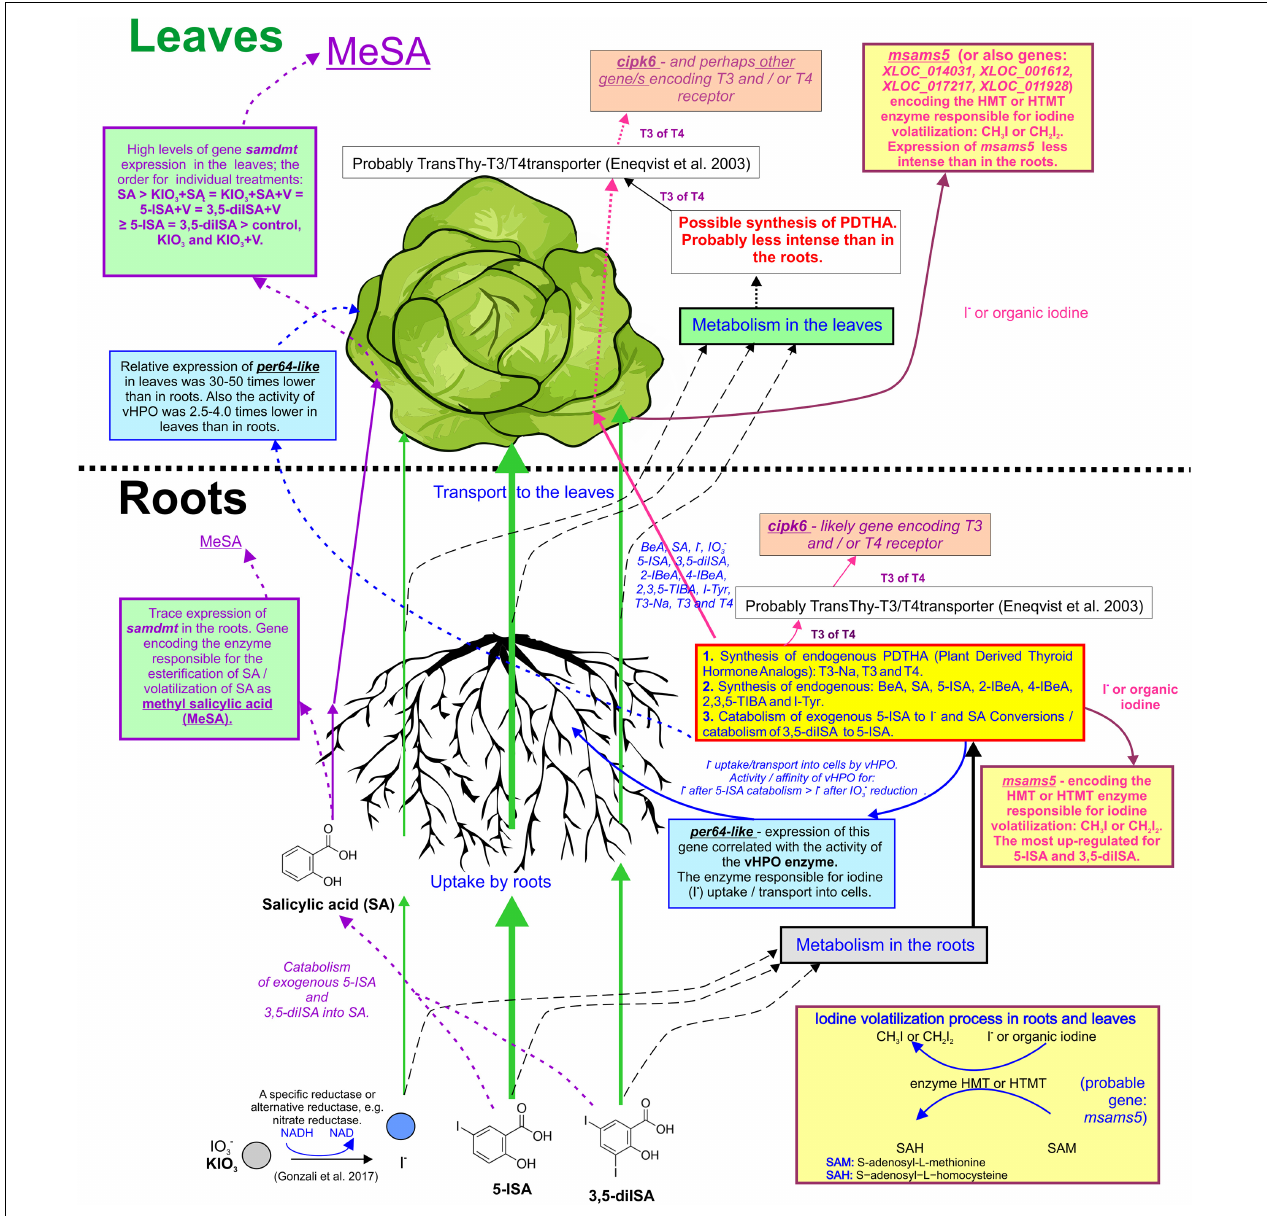
FIGURE 6 | Graphic summary of study outcomes: uptake, transport, and metabolic pathways of iodine compounds and SA. Genes with described activity and function: Peroxidase 64-like (per64-like) : the gene’s activity has been linked to the activity/functionality of V-dependent haloperoxidase (vHPO) in roots and leaves of lettuce. Peroxidase 12-like (per12-like ): no correlation has been found between the gene’s expression and vHPO activity in roots. S-adenosyl-L-methionine-dependent methyltransferase (samdmt) : gene that possibly encodes an enzyme that conducts the process of esterification/volatilization of methyl salicylic acid (MeSA). CBL-interacting serine/threonine-protein kinase 6 (cipk6): gene that likely encodes triiodothyronine (T3) and/or thyroxine (T4) receptors. S-adenosylmethionine synthase 5 (msams5): gene that possibly encodes an enzyme responsible for I volatilization in the process of methylation (synthesis of CH 3 I or CH 2 I 2